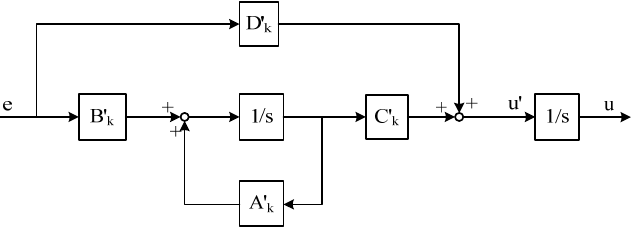
Figure 2. Special LPV controller that needs no modification.